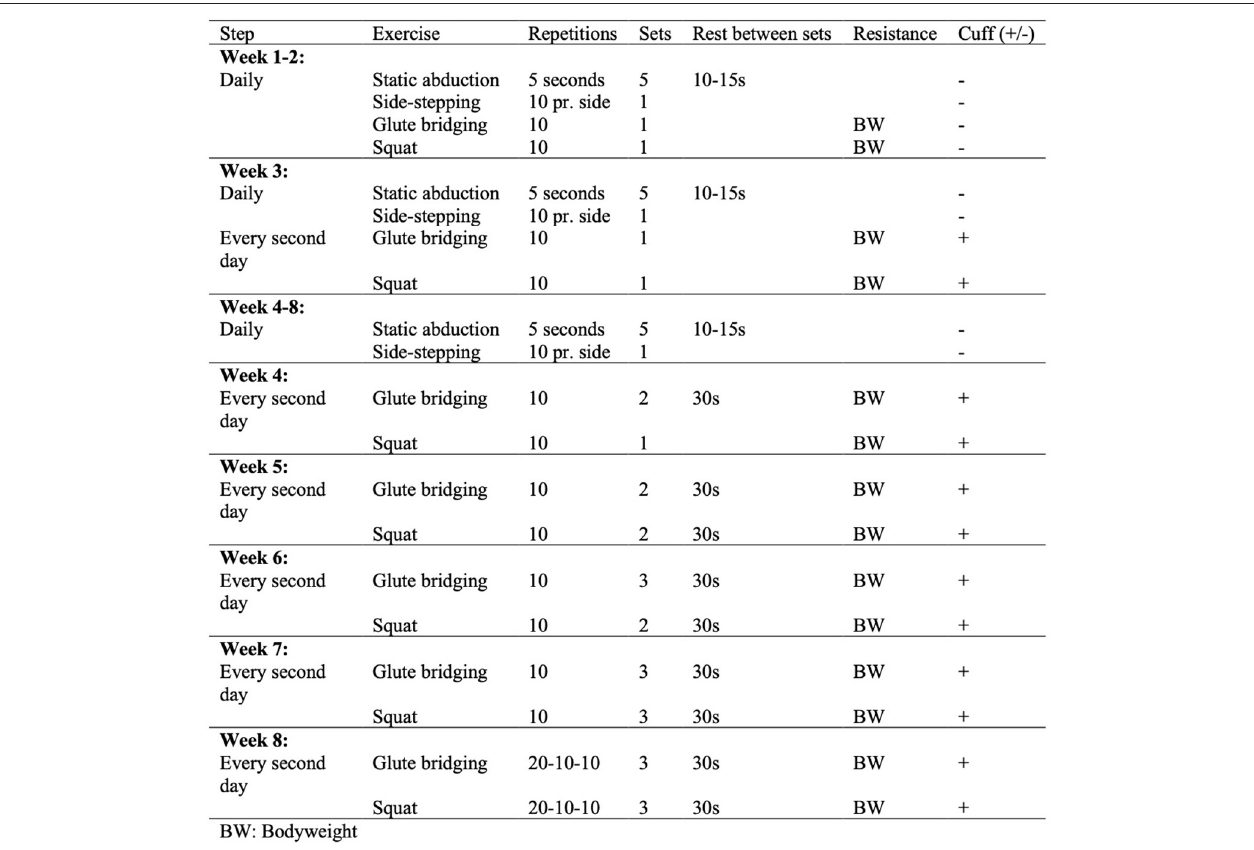
FIGURE 2 | Exercise